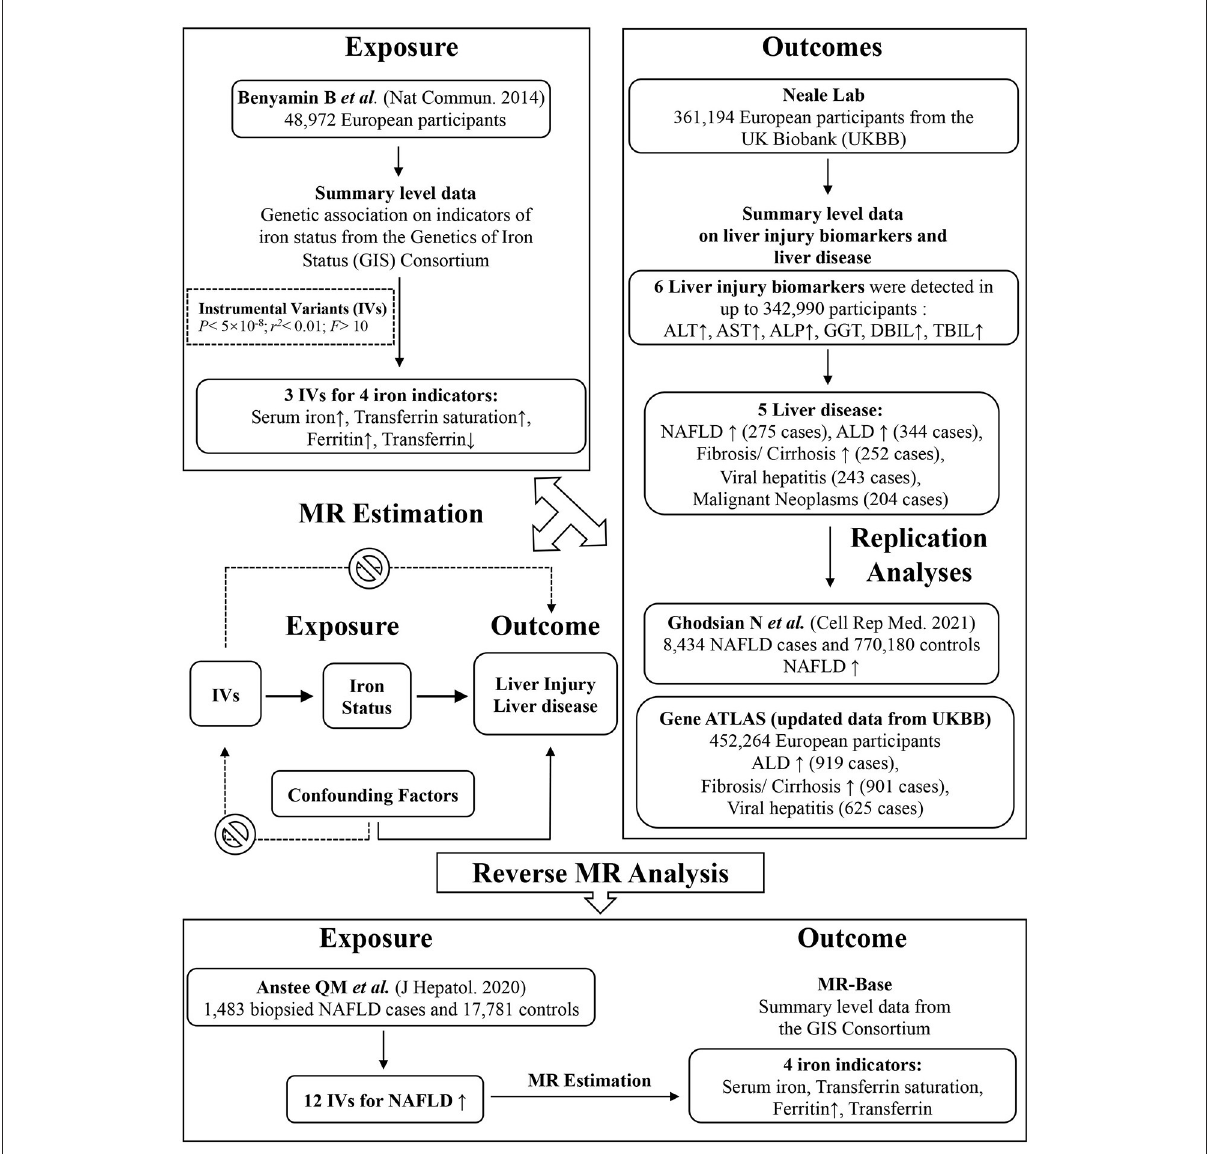
FIGURE1 Graphical overview of the two-sample MR study design. Three SNPs, each of which has a genome-wide significant association with increased serum iron, increased ferritin, increased transferrin saturation and decreased transferrin levels, were used as instruments for systemic iron status. By using genetic instruments associated with these four iron status biomarkers, the MR approach can be used to estimate the causal effect of systemic iron status on the risk of liver function (biomarkers including ALP, ALT, AST, GGT, DBIL, TBIL) and liver disease (NAFLD, ALD, fibrosis and cirrhosis, viral hepatitis, malignant neoplasm). Replication and reverse MR analyses were performed in the largest available GWAS studies. MR, Mendelian randomization; SNP, single-nucleotide